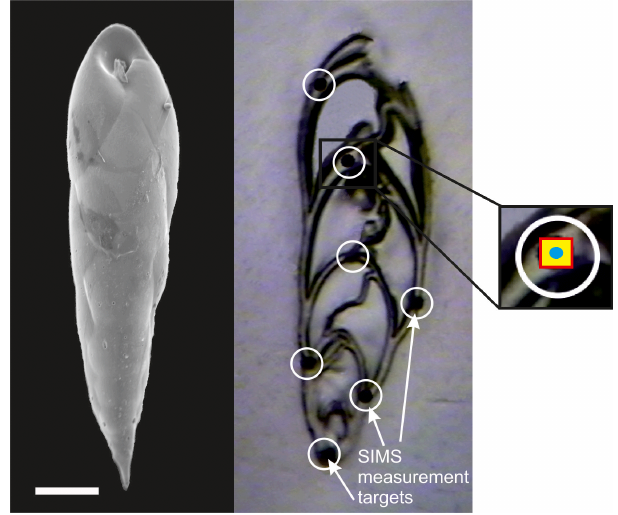
Figure 2. SEM image (scale bar: 100µm) and cross-section image during SIMS analysis of a single Eubuliminella exilis specimen. The white circles highlight the selected spots for SIMS analyses, mea- suring 5µm in diameter. Note that the black areas of the SIMS mea- surement targets visible in this image are actually the 5µm spots plus the 10µm pre-sputters. Inset is a close-up of the SIMS targets: the red square is the approximate pre-sputter area (15 × 15µm, i.e. 5µm spot + 10µm raster), the yellow area is the field of view admit- ted to the mass spectrometer (controlled by magnification and field aperture) and the blue ellipse is the nominal 5µm